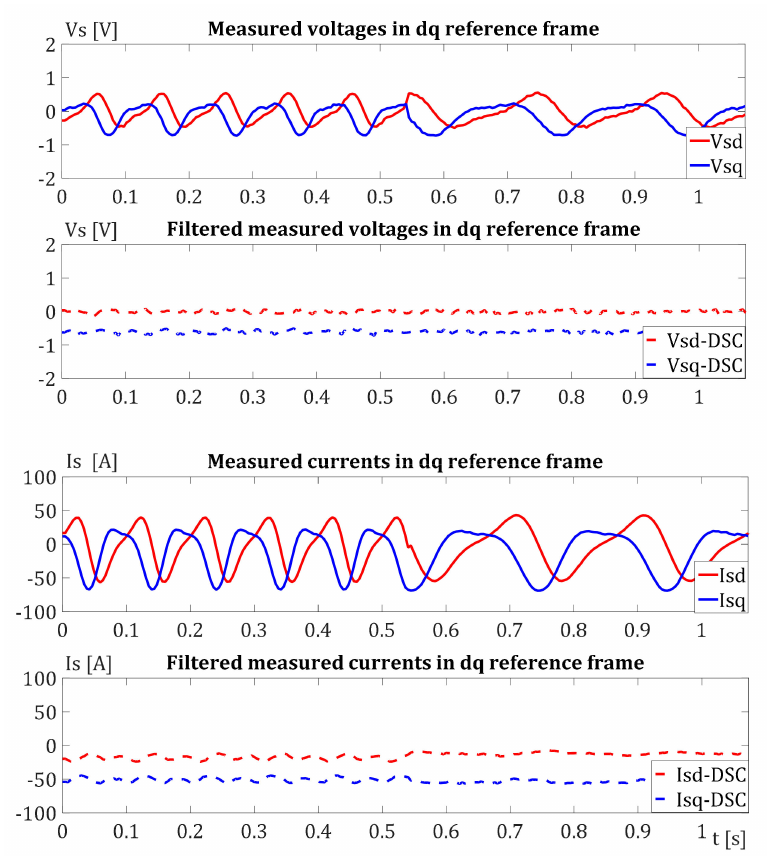
Figure 10. Experimental results for voltage and current in the dq reference frame during voltage test